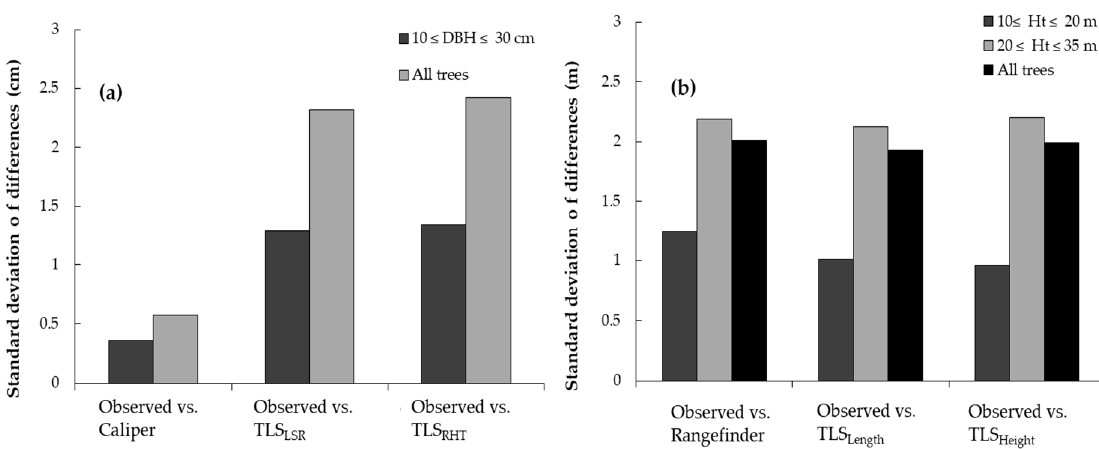
Figure 6. ( a ) The standard deviation of differences between the estimated versus observed diameter and for three different methods, i.e., traditional measurement (TM observed) vs. fieldmap (FM caliper) and terrestrial laser scanning (TLS RHT and TLS LSR ), and ( b ) the standard deviation of differences between estimated versus observed tree height, i.e., measured manually (TM observed) versus fieldmap (FM rangefinder), as well as TLS Length (tree length) and TLS Height (tree